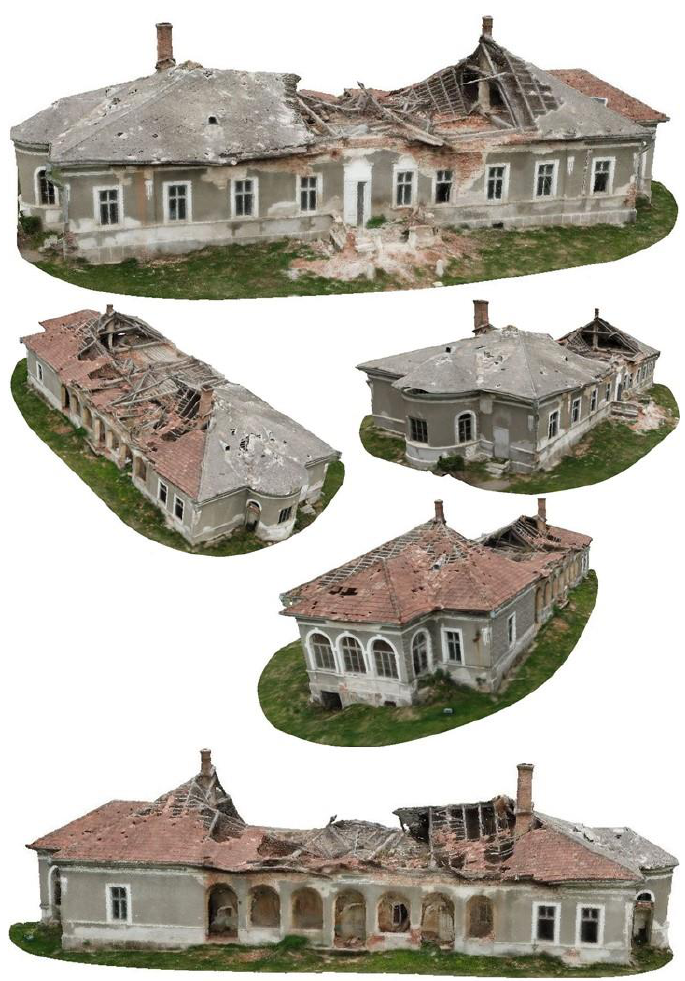
Figure 11. Photorealistic 3D model.